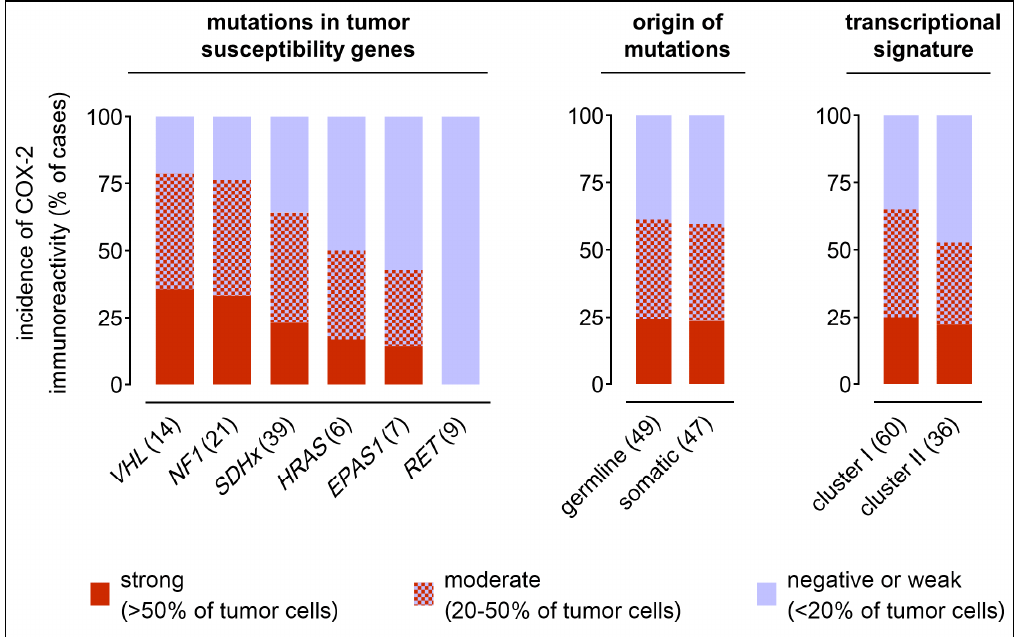
Figure 3. Comparison of COX-2 immunoreactivity in PPGLs in respect to genetic background; incidences of strong, moderate, and negative or weak COX-2 immunoreactivity observed among 96 tissue samples classified with regard to specific mutations in tumor susceptibility genes, origin of mutations, and transcriptional cluster; numbers in parentheses represent the number of samples investigated in each subgroup; see Table S1 for statistical analyses.